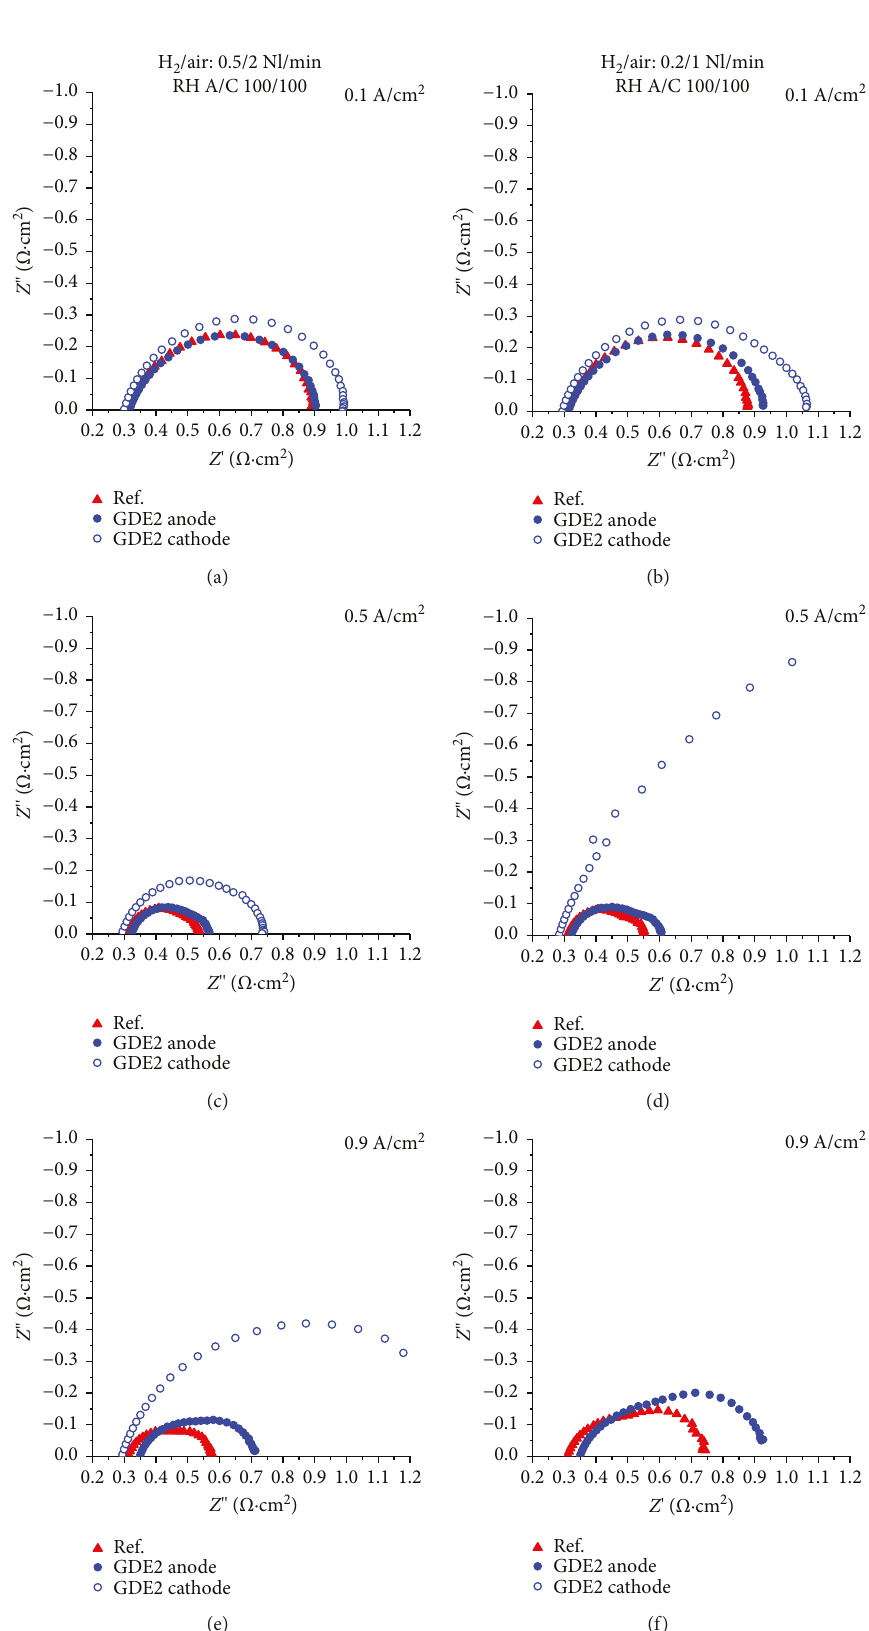
Figure 6: Example of impedance spectra acquired at di ff erent current densities (i.e., from 0.1 A/cm 2 to 0.9A/cm 2 ) at high (a, c, e) and low (b, d, f) inlet gas fl ow rates for the reference sample, GDE2 anode, and GDE2